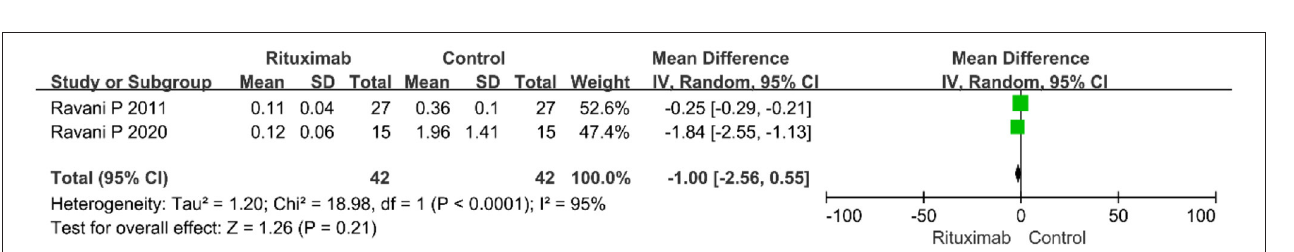
FIGURE 5 | Forest plot showing a meta-analysis of serum creatinine between rituximab treatment group and control group.